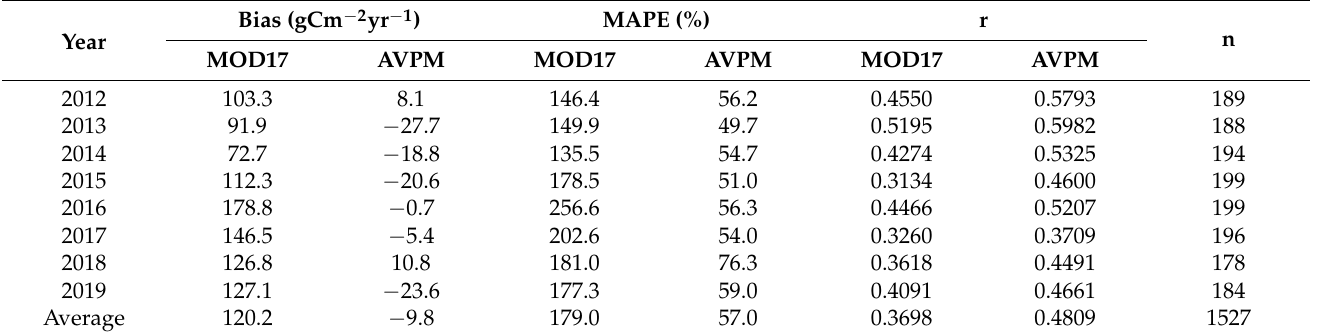
Table 1. Accuracy assessment of the AVPM model and MOD17 NPP from 2012 to 2019 and their bias, MAPE, and r, respectively. MAPE: mean absolute percent error; r: Pearson’s correlation coefficient; AVPM: alpine vegetation photosynthesis model.